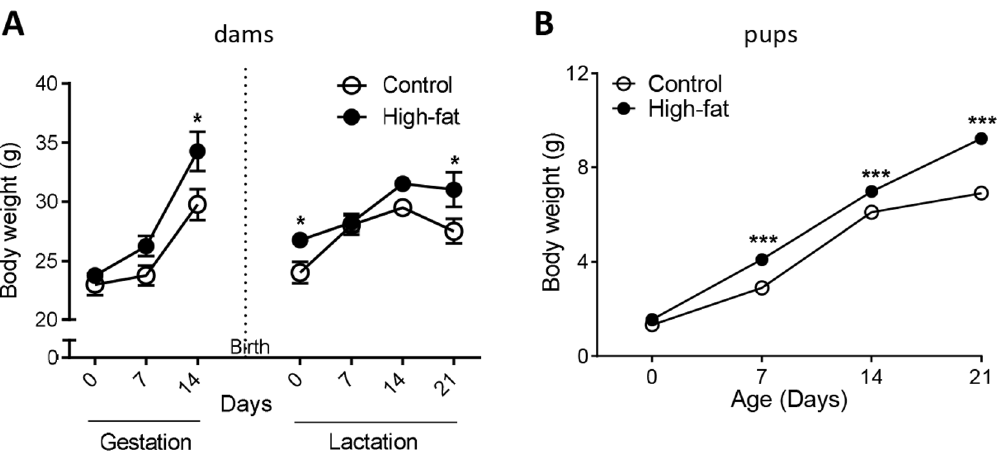
Figure 1. A high-fat diet during pregnancy and lactation increases bodyweight in 3xTgAD dams and offspring mice. Bodyweight (g) of female dams during pregnancy and lactation (A) and, offspring mice (of mixed sex) after birth and during lactation (B). Data are mean 6 SEM for n =4/group for dams and n =23–30/group for pups. * P , 0.05, *** P , 0.001 versus control fed groups.